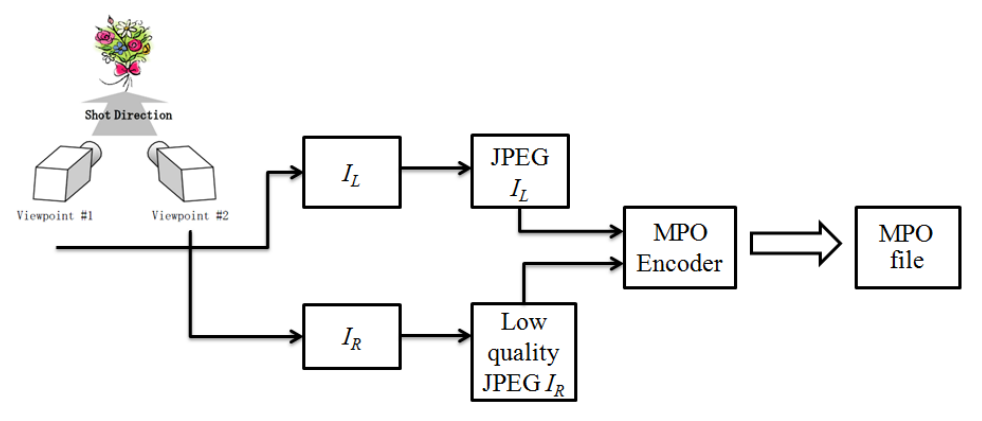
Figure 1. Encoding pipeline. Each view is coded according to the MPO format (i.e., by applying the JPEG compression) using different quality